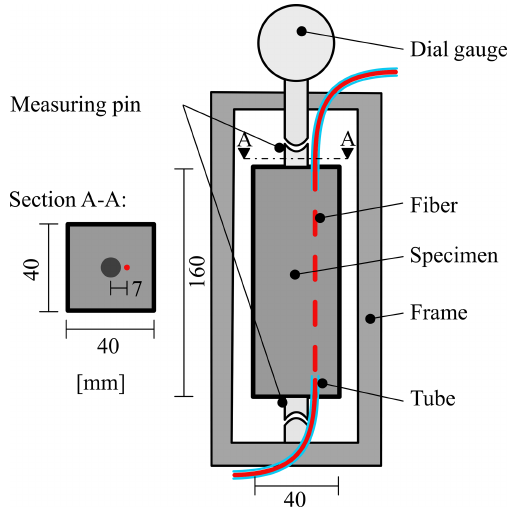
Figure 6. Arrangement of the test specimen and test